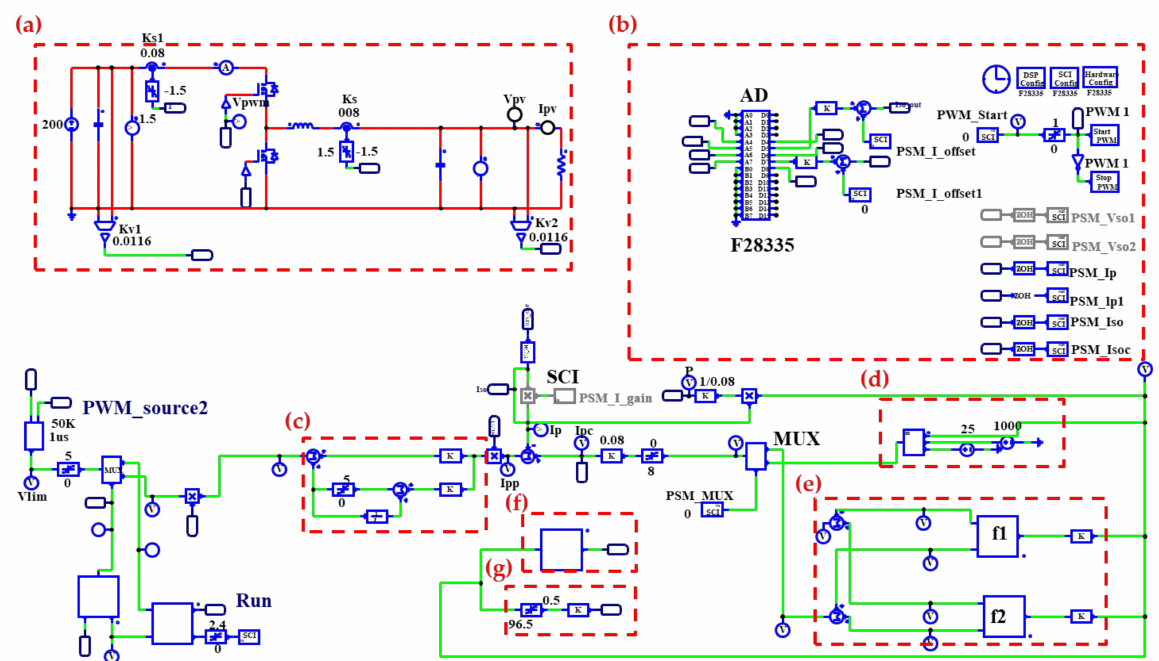
Figure 11. Complete simulation model of the proposed PV emulator and the arrangement of control signals. ( a ): buck- boost converter, ( b ): analog to digital module, ( c ): current controller, ( d ) and ( e ): PV model blocks, ( f ) and ( g ): voltage command